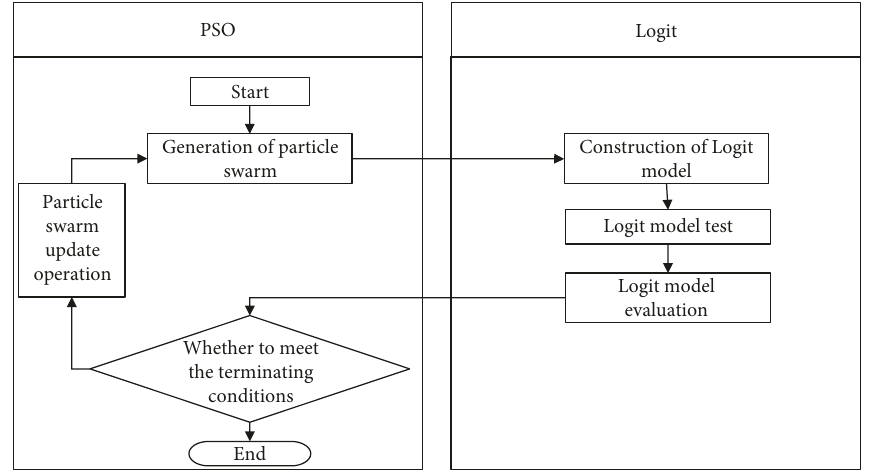
Figure 6: PSO algorithm and logit